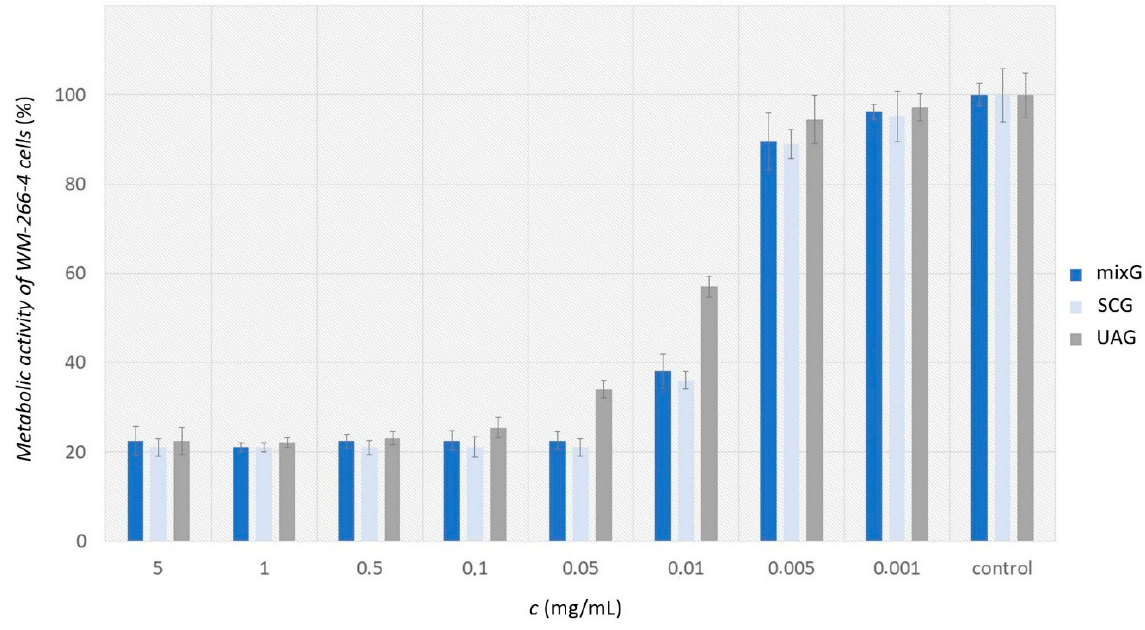
Figure 3. Metabolic activity of metastatic cells WM-266-4 after applying the extract of selected con- Figure 3. MetabolicactivityofmetastaticcellsWM-266-4afterapplyingtheextractofselected concentrations. centrations.